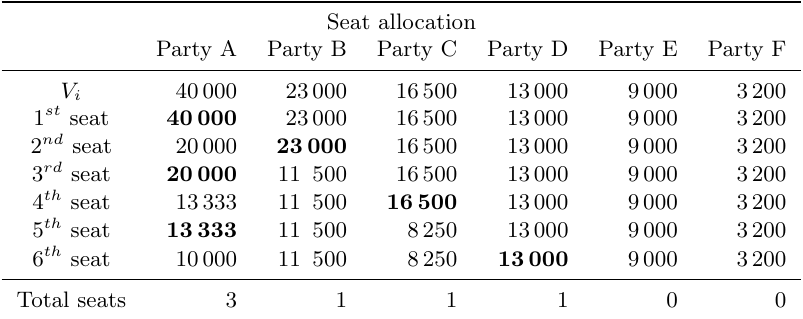
Table 1: An illustration of d’Hondt’s method of allocating seats proportional to votes.